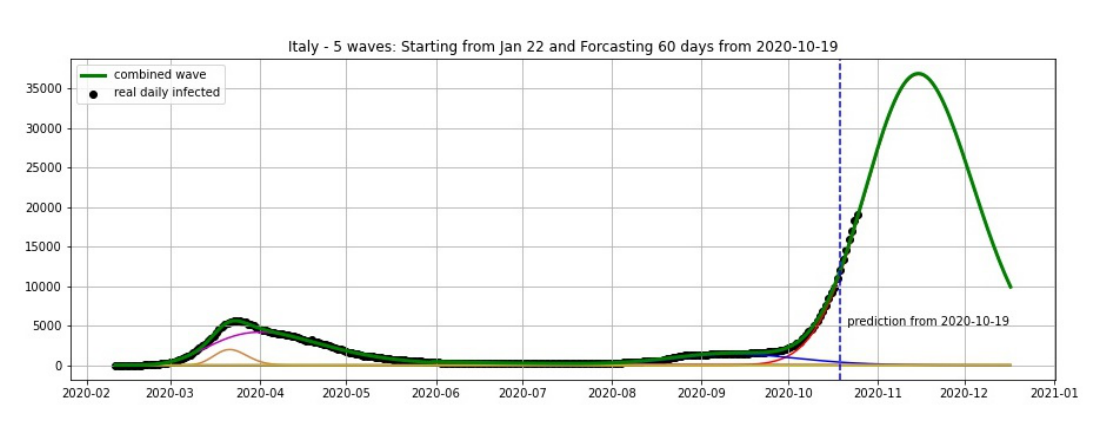
Figure 10. Italy: fitting and forecasting from 25 October with 5 wavelets. The green curve is the combination of other curves which are EF wavelets.